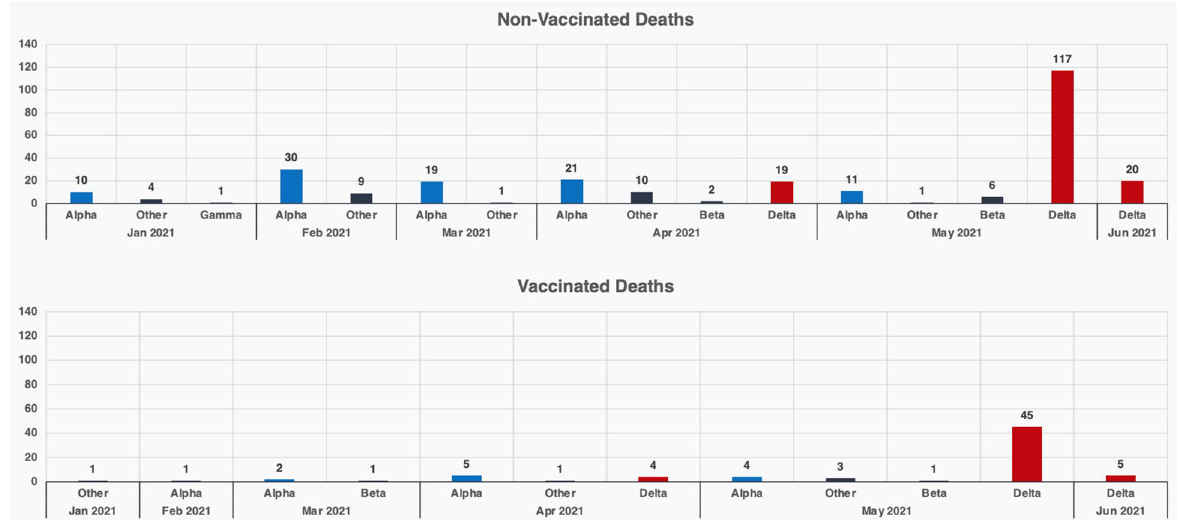
Figure 5. Variant sequencing for SARS-Cov2 infected individuals who died (presumptively from SARS-Cov2 infection). Variants detected between January 1 2021 to June 30 2021 are shown in the following brackets: